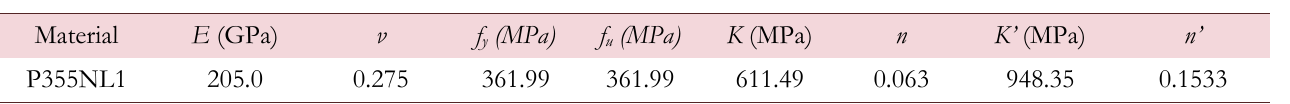
Table 1: Elastic, monotonic tensile and Ramberg-Osgood properties for the P355NL1 steel. Material